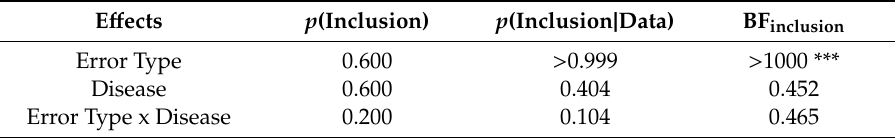
Figure 2. Conditional error probabilities. Large circles indicate mean conditional error probabilities. Error bars indicate the 95% credibility interval. Small circles indicate individual conditional error probabilities. Table 1. Analysis of effects of error type and disease on conditional error probabilities.